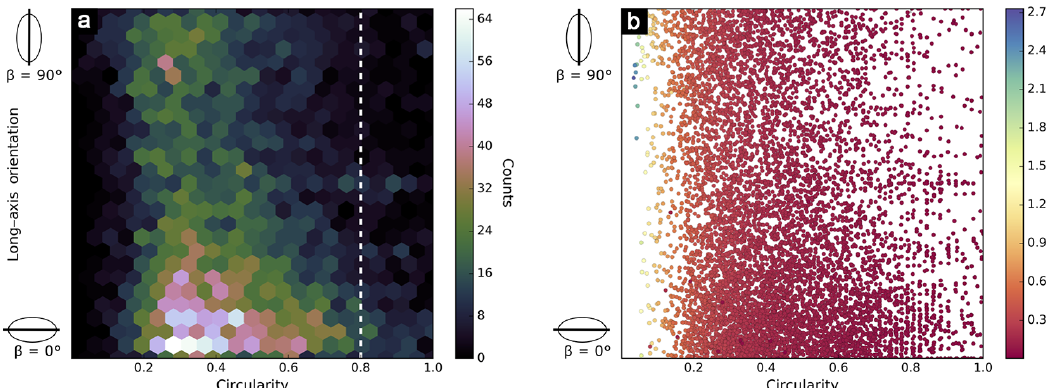
Figure 4. The link between pore orientations, pore sizes and their shapes in detail. Figure 4 presents only data for pores with circularity values < 1. A delineation (circ = 0.8) is presented to show the change in power-law relations observed in Fig. 3c. Panel (a) shows that with decreasing circularity there is an increase in the variability of β values. Panel (b) presents the same data as Fig. 4a but with the data points coloured for cross-sectional area. The largest pores are observed to mostly have high β values.